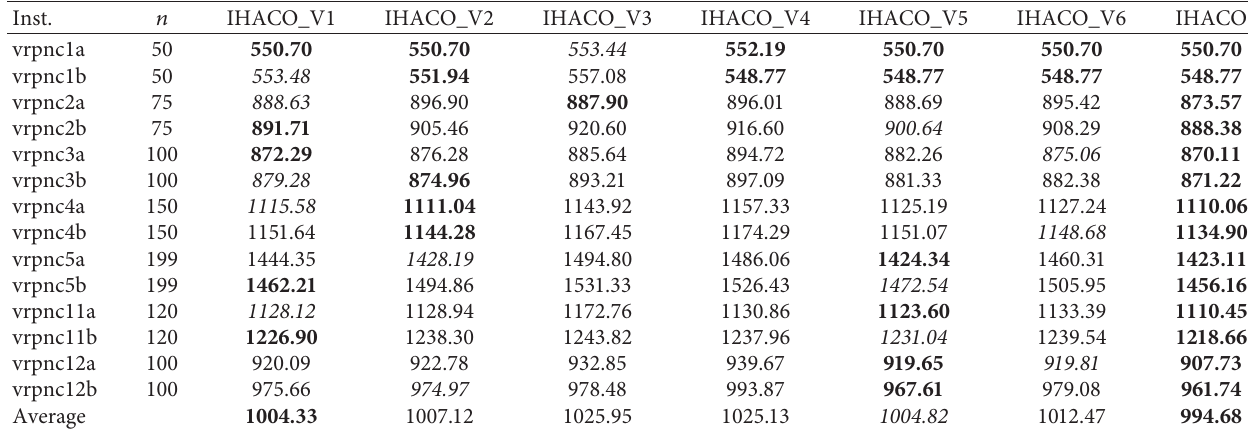
Table 3: Comparison results of IHACO and its